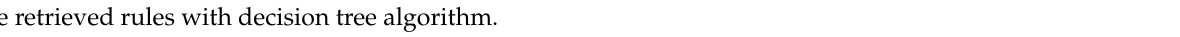
Table 3. Extracted rules via DT, HT and RF